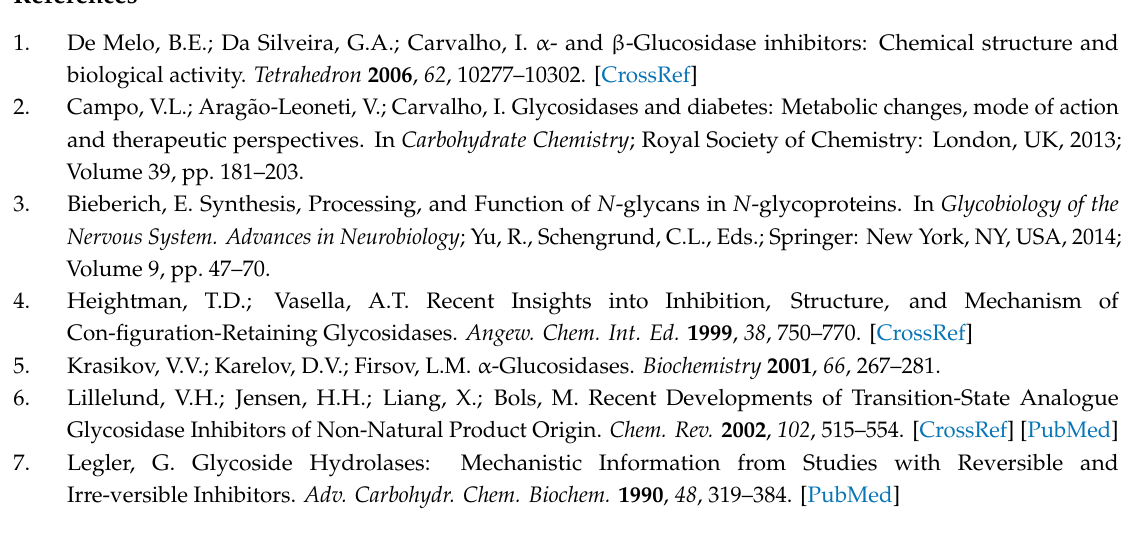
Supplementary Materials: The following are available online, Table S1: The dataset used for model development Table S3: The results of prediction performed for BIOFACQUIM database, SANNs.zip file containing PMML codes of